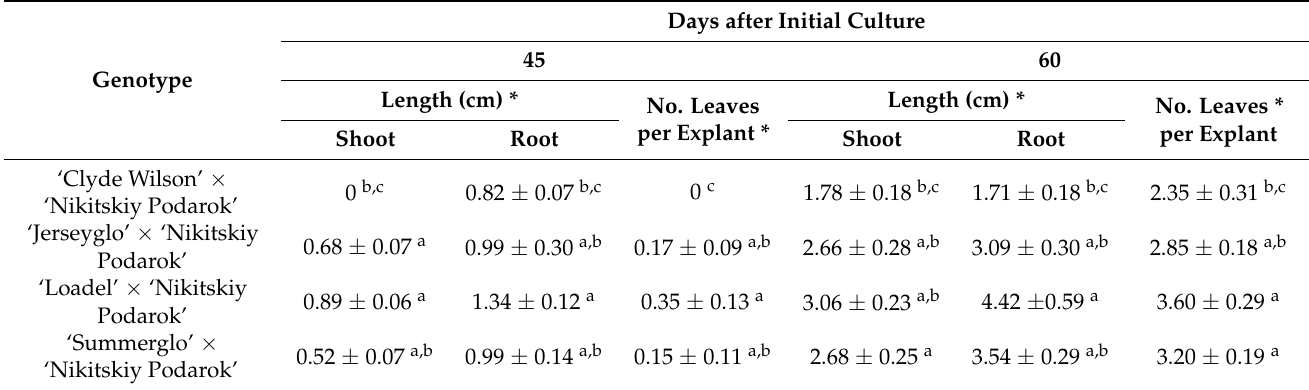
Table 1. Germination of hybrid peach embryos on Monnier culture medium, depending on the duration of stratification at 4 ◦